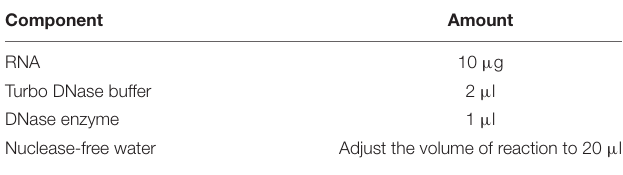
TABLE 6 | DNase treatment reaction setup.